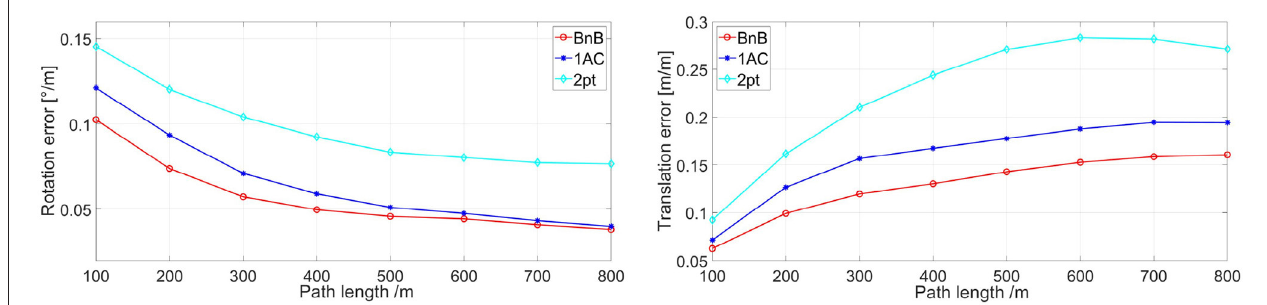
FIGURE 6 | Rotation and translation error of three algorithms. They are exhibited with respect to path length. 1AC, 2pt are the studies of Choi and Kim (2018); Guan et al. (2020), respectively, and BnB is our study. Better viewed in color. is fixed to 200, and we add the different ratios of outliers in sampled feature matchings ranging from 0 to 90%. The median value of inlier _ max in 200 repetitions is adopted for evaluation.